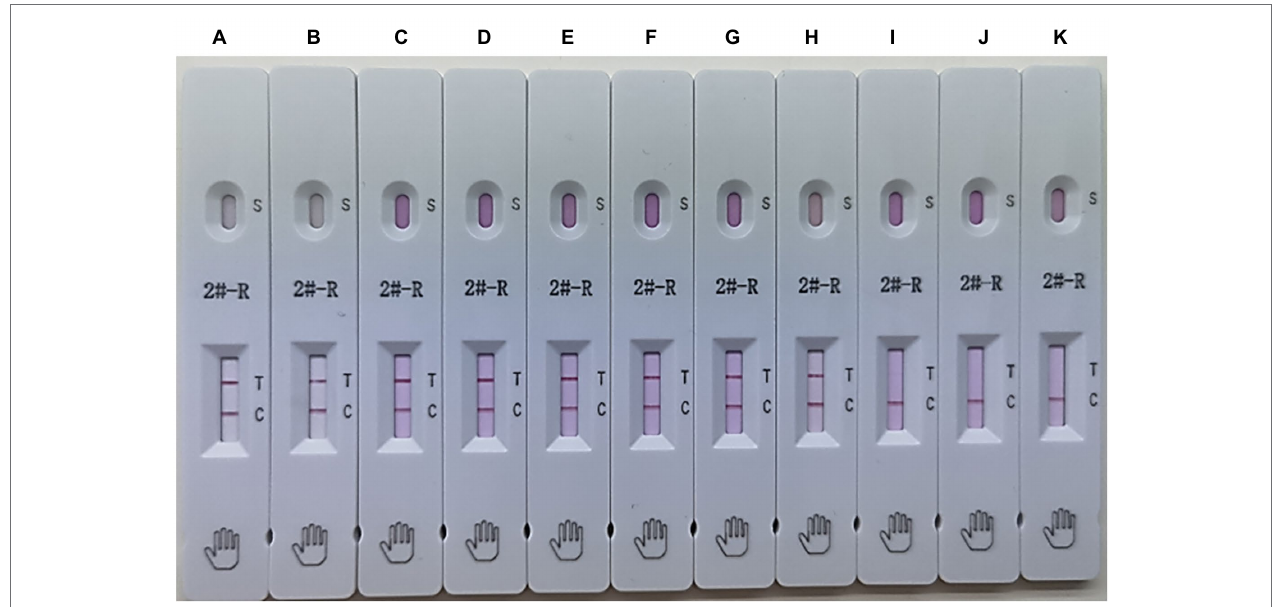
FIGURE 6 | Applicability of the ICS. Several types of PRRSVs were tested using the ICS assay developed in this study: HuN4 (HP-PRRSV; strip A ), HuN4-F112 (HuN4 vaccine; strip B ), TJM-F92 (HP-PRRSV vaccine; strip C ), JXA1-R (HP-PRRSV vaccine; strip D ), CH-1R (classical PRRSV vaccine; strip E ), MLV (classical PRRSV vaccine; strip F ), SDHS53 (NADC30-like PRRSV; strip G ), TZJ1341 (NADC34-like PRRSV; strip H ), VP046 BIS (EU-PRRSV vaccine; strip I ), DV (EU-PRRSV; strip J ), and control (DMEM; strip K ).